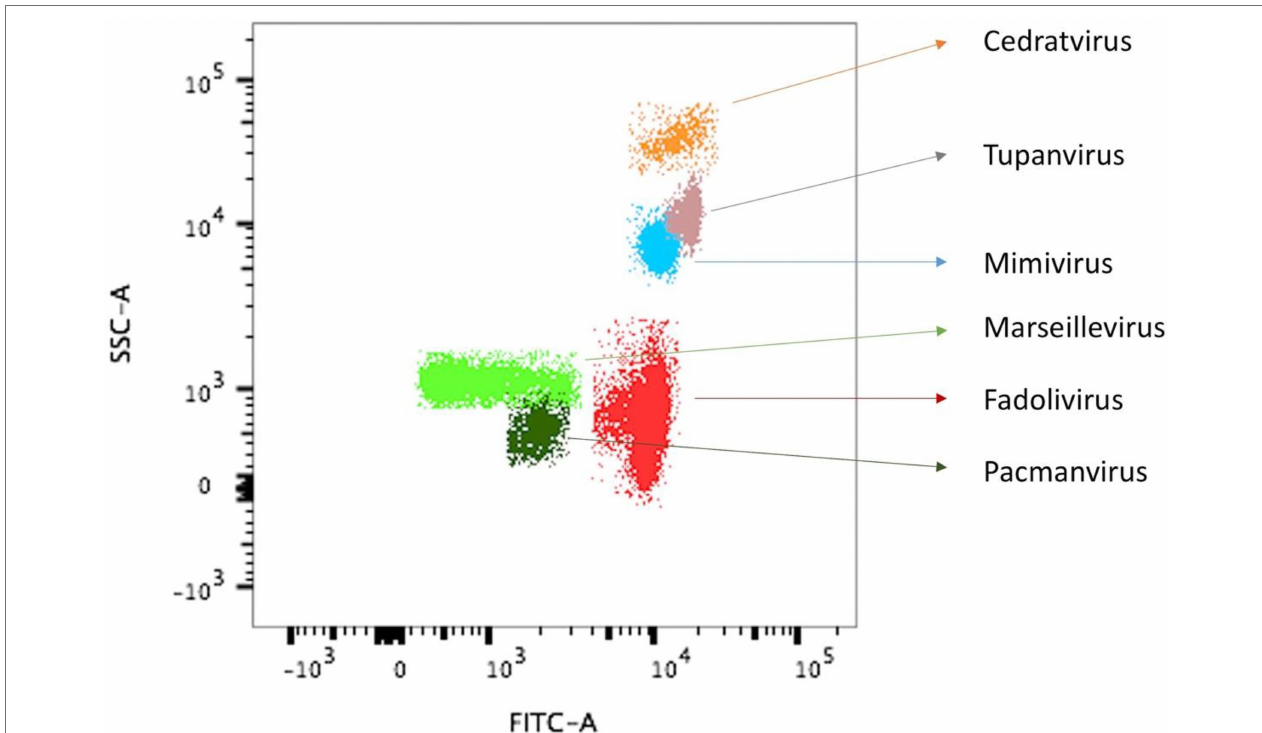
FIGURE 1 | Observation of virus isolate VV54 sample on flow cytometry superimposed with that of other known viral isolates. Flow cytometry dot plot showing different viral profiles, in SSC (side scatter) versus FITC (Fluorescein isothiocyanate) SYBR green DNA contents, distinguishable at the levels of capsid shape (optical properties) and DNA components. For the sample VV54, the single viral population (Fadolivirus) is shown in red. For comparison, gates from previous isolates of other viral strains are